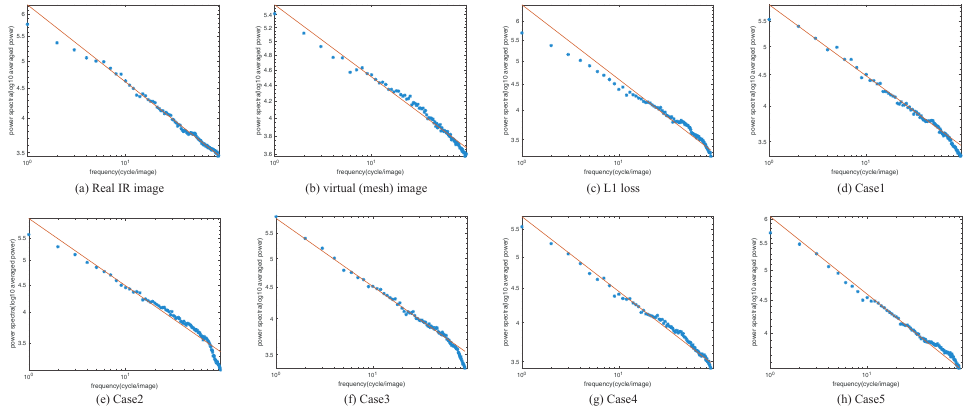
Figure 8. Power spectrum analysis for the constructed image by CycleGAN proposed and a natural IR